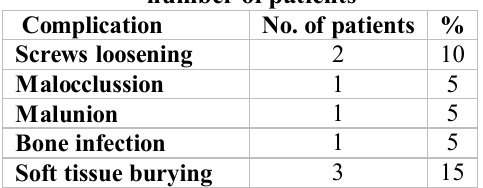
Table 5: Complications related to the